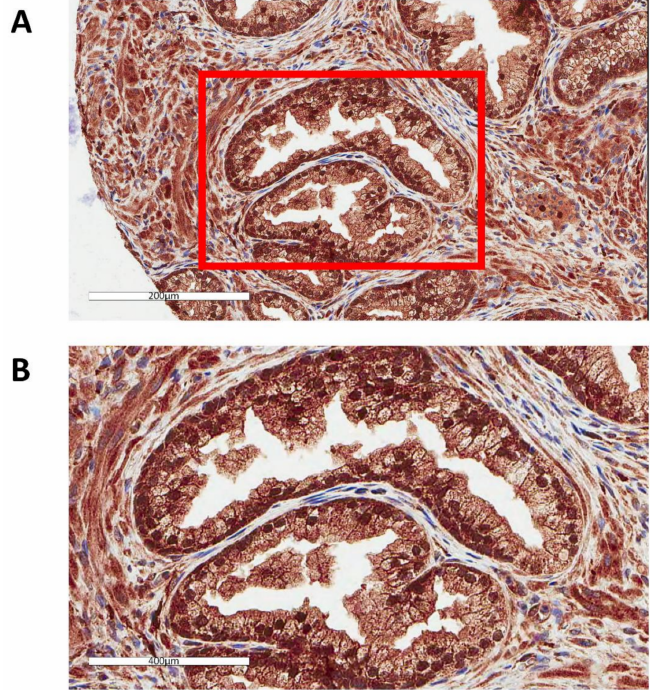
Figure 1. Localization of GPX1 in the nuclei of prostate epithelial cells. ( A ) Representative image of human prostatic tissue immunostained with anti-GPX1 antibodies, including highlighted portion of the upper image at a higher magnification ( B